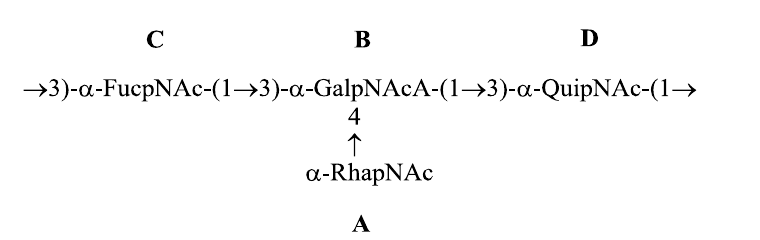
Figure 3. Structure of the repeating unit from P. shigelloides O24 (strain CNCTC 92/89). The 1 H- and 13 C-NMR data of the O-specific repeating unit from P. shigelloides O24 were identical to those obtained for the capsular polysaccharide from clinical isolate Vibrio vulnificus strain BO62316 [1,14] indicating that these two compounds have the same structure. The α-Fuc p NAc and α-Gal p NAcA residues were reported to have the D configuration while α-Qui p NAc and α-Rha p NAc had the L